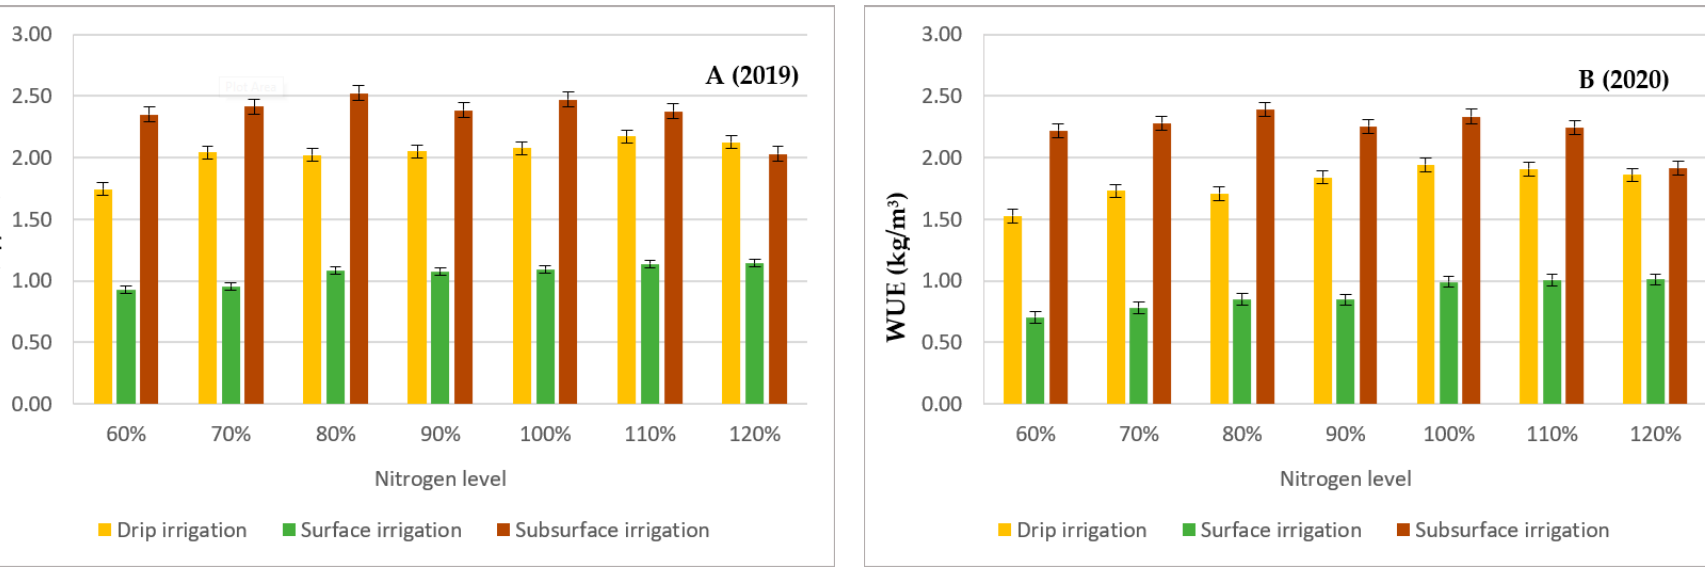
Figure 2. The water use efficiency (WUE) at the different applied irrigation systems and nitrogen levels (%) and irrigation systems at seasons 2019 ( a ), 2020 ( b ).